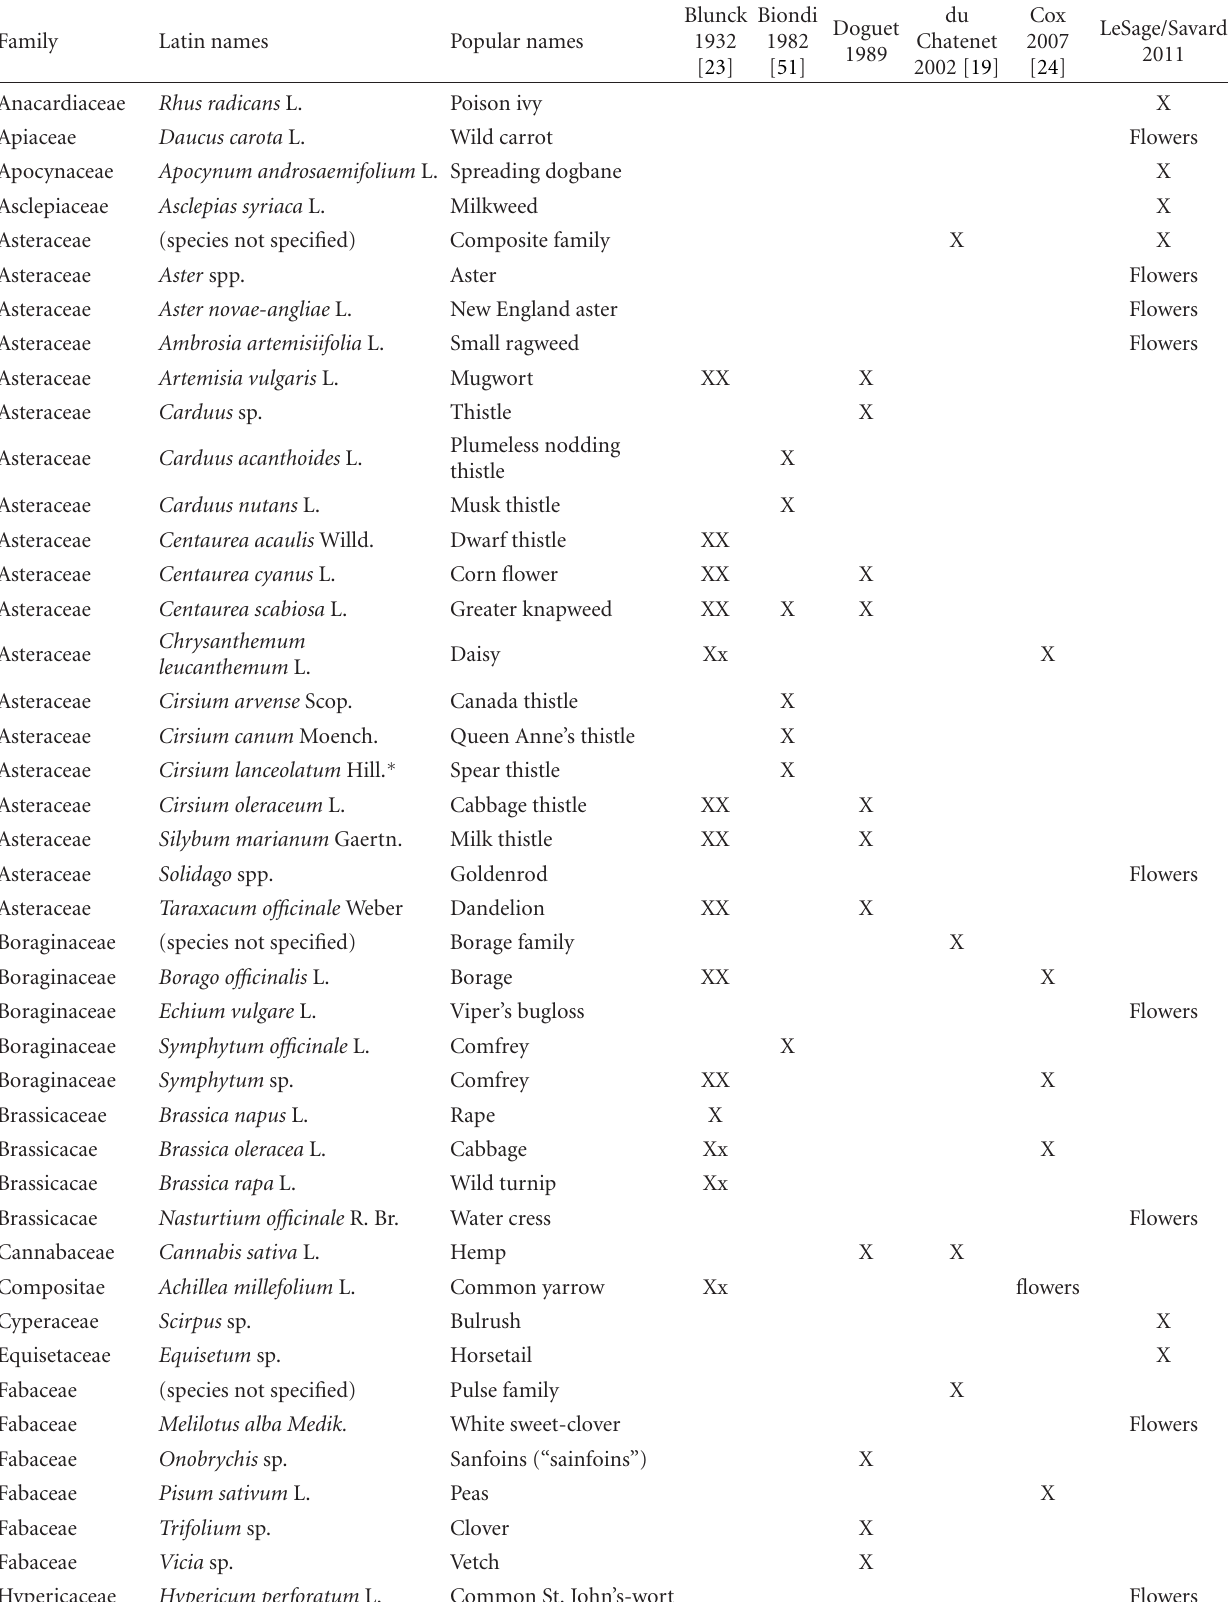
Table 1: Most important lists of recorded host plants for Neocrepidodera ferruginea . The list of Blunck [23] includes only the first two